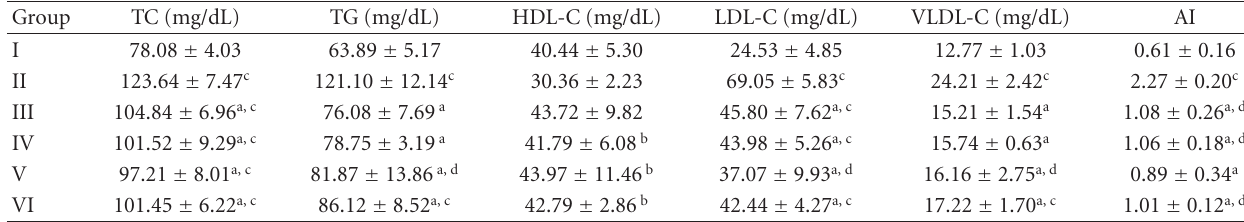
Table 2: E ff ect of antioxidant vitamins on lipid profile and atherogenic index.